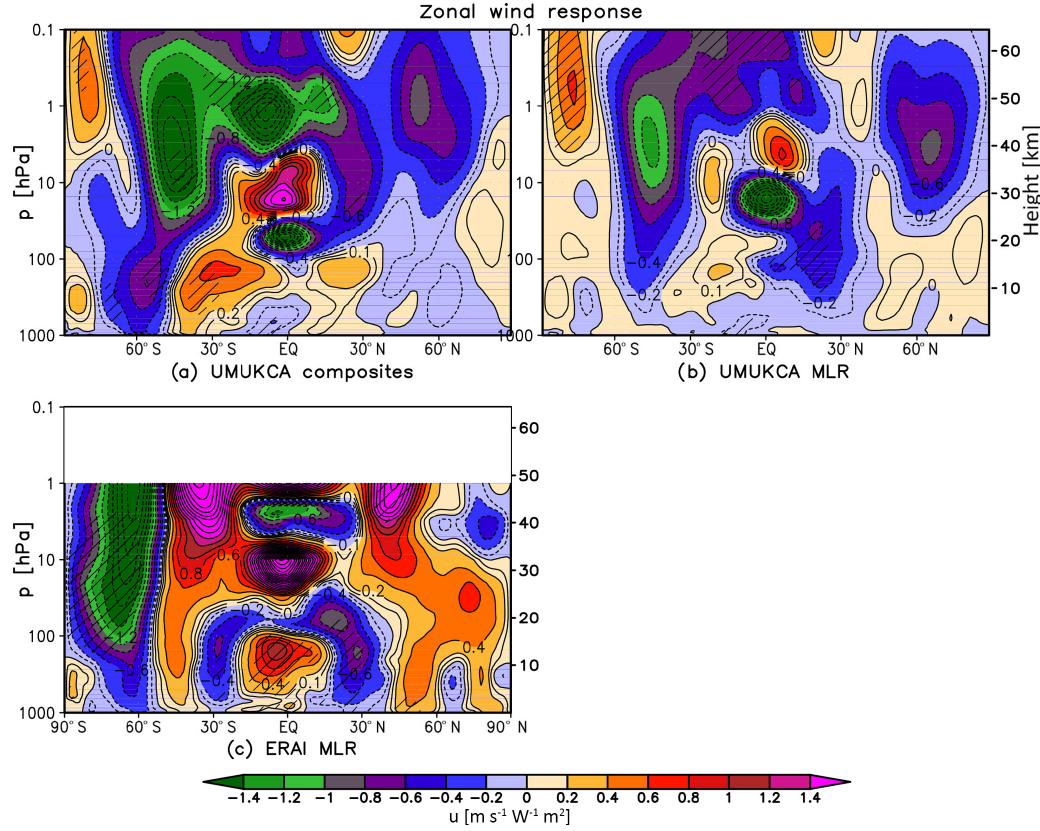
Figure 4. As in Fig. 3 but for the zonal mean zonal wind response (ms − 1 W − 1 m 2 ). Contour spacing is 0.2ms − 1 W − 1 m 2 ; note also the additional contour at ± 0 . 1ms − 1 W − 1 m 2